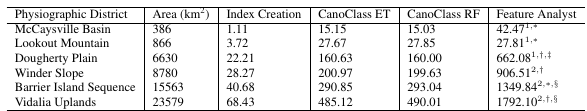
Table 2. Computational times in minutes. Index creation times are shown separately to give context to the additional times the method used by CanoClass utilizes. CanoClass ET/RF times do Figure 5. Tiles 1, 2, 10, 11, and 13 from Table ?? in that order not include the time to create the indices and is only the time to from left to right showing the 2015 NAIP tiles, the raster outputs classify and save the raster. Feature Analyst times similarly of the ET classification within CanoClass, Feature Analyst, and shows the amount of time to classify and save the output. 1: the raster visualizing the F w values of each cell showing the Windows system 1. 2: Windows system 2. *: Shapefile outputs. differences between the classified outputs with a window of † : GeoTIFF outputs. ‡ : Simultaneous runs with other two w = 3 districts that were not used in this study. § : The three outliers from Figure 3a were replaced by the average tile processing time.